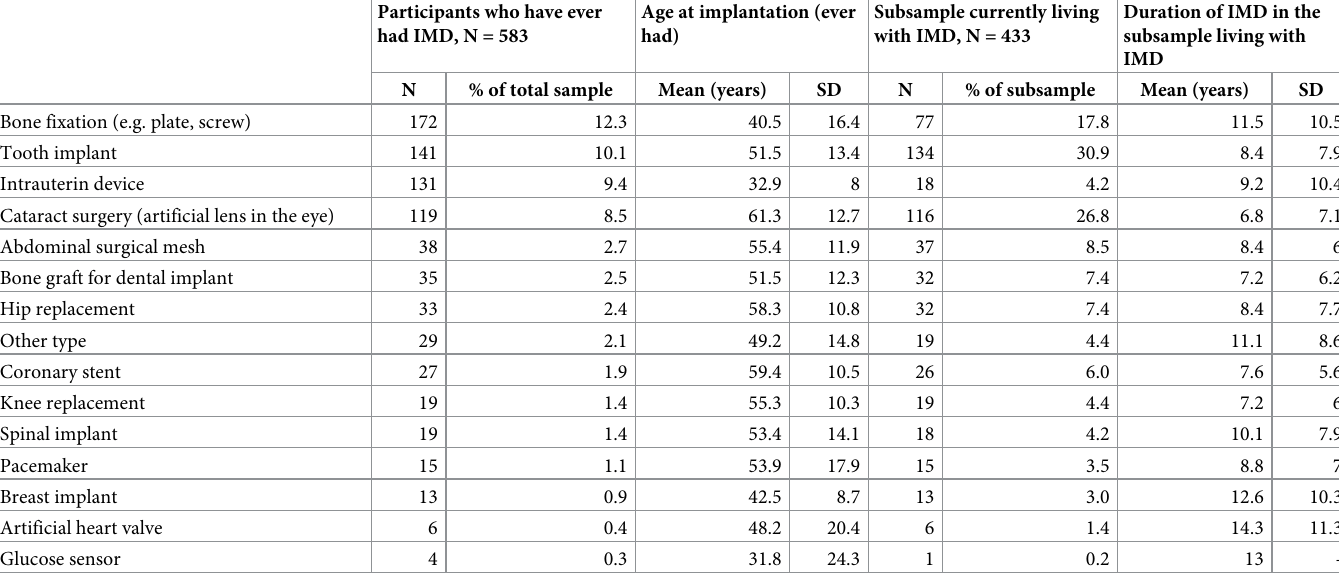
Table 2. Prevalence and duration of implantable medical devices